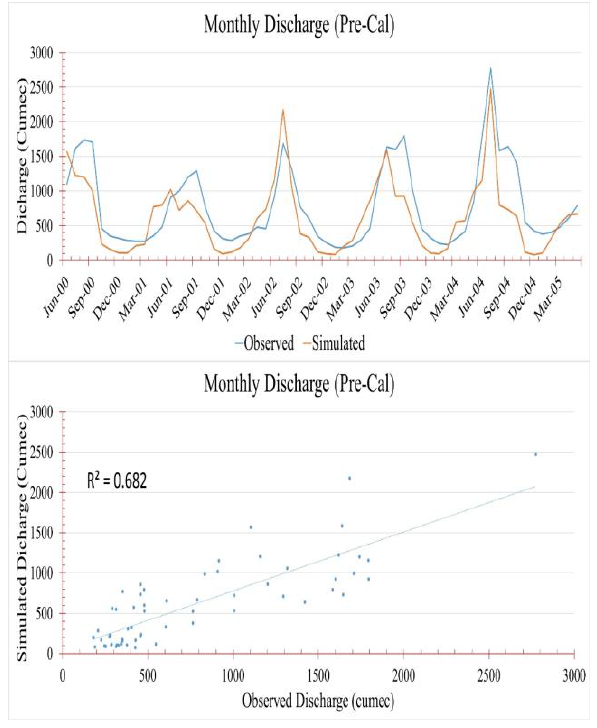
Figure 4 . Pre Calibration